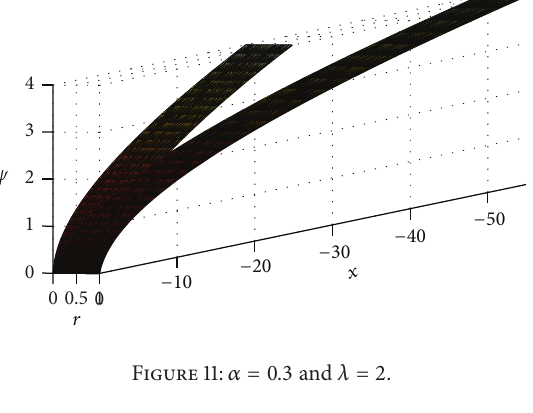
Figure 13: 𝛼 = 0.3 and 𝜆 = 2 .